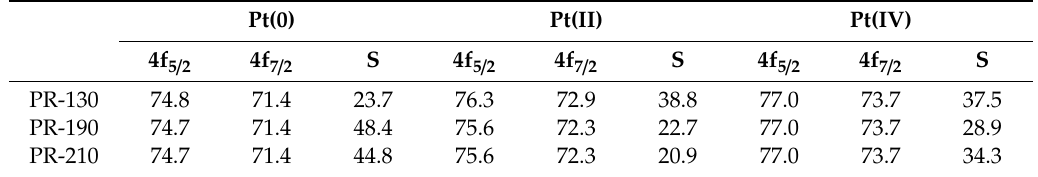
Table 1. Binding energies (eV) and relative proportions (S, in %) of each component measured by XPS.